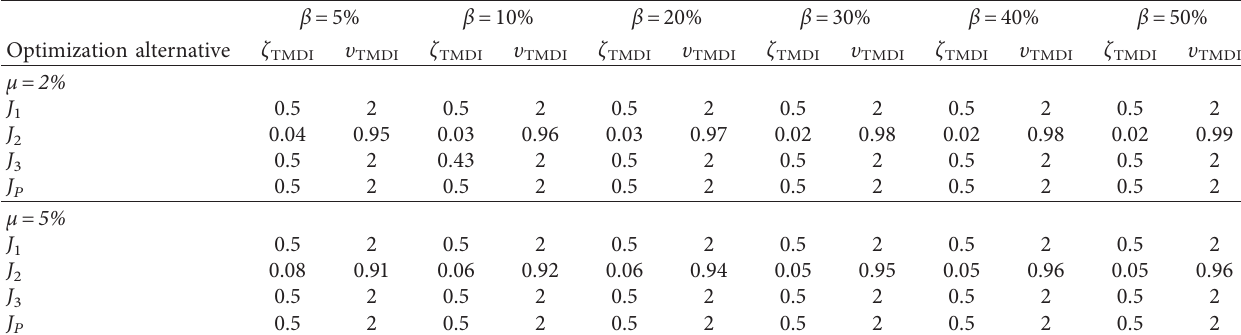
Table 9: TMDI optimization parameters for µ � 0.02 and µ � 0.05 for the structure subjected to the “ Kobe ” record. β �